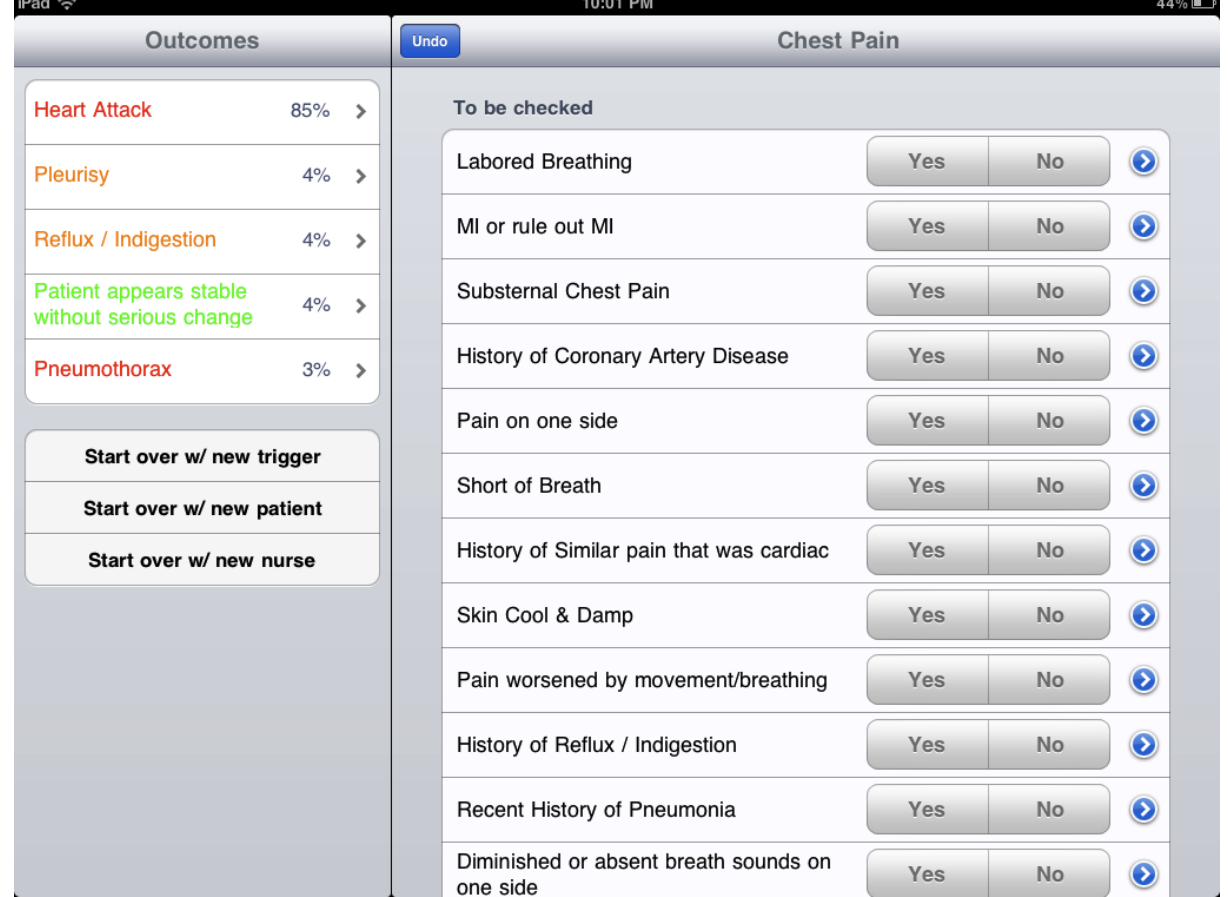
Figure 1. The main split screen user interface of the decision support system.